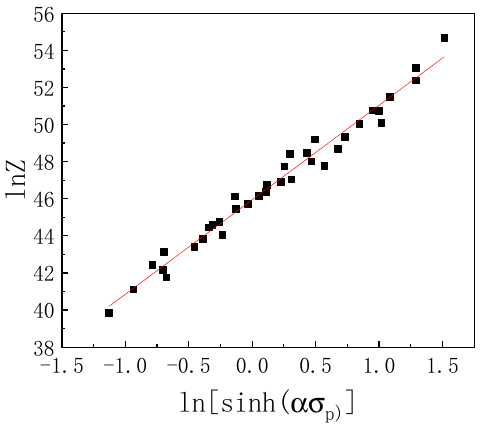
Figure 5. Relationship of Z parameters and peak stress.